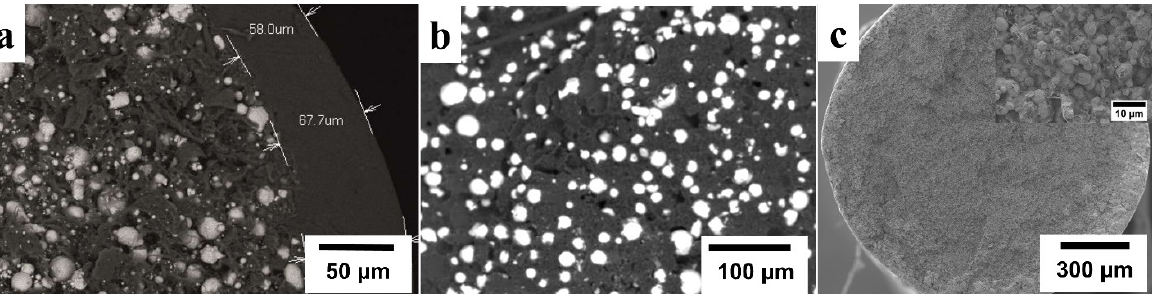
Figure 6. Cross-sectional view of the commercial filaments—( a ) Ultrafuse by BASF (adapted from [4]), showing polymer skin surrounding mixing of polymer and metal powder, ( b ) 316L metal filament by Virtual foundry (adapted from [72]) and ( c ) 17-4PH stainless steel filament for MetalX system by Markforged, Inc. (Reprinted with permission from ref. [8]. Copyright 2021, Metallurgical and Materials Transactions A, Springer).